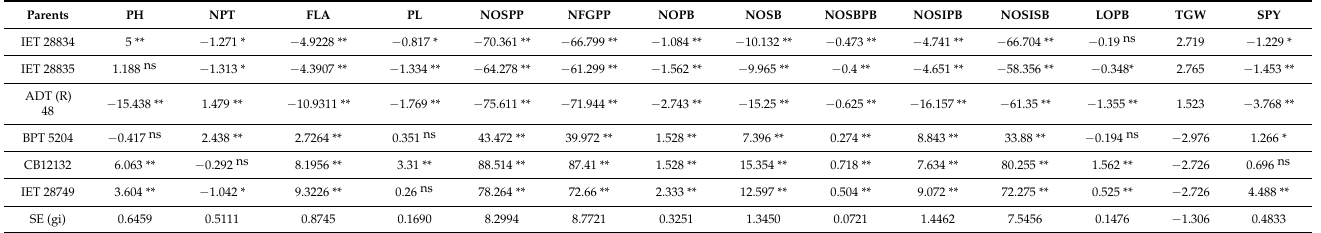
Table 7. General combining ability effects of parental genotypes to 14 panicle- and yield-related